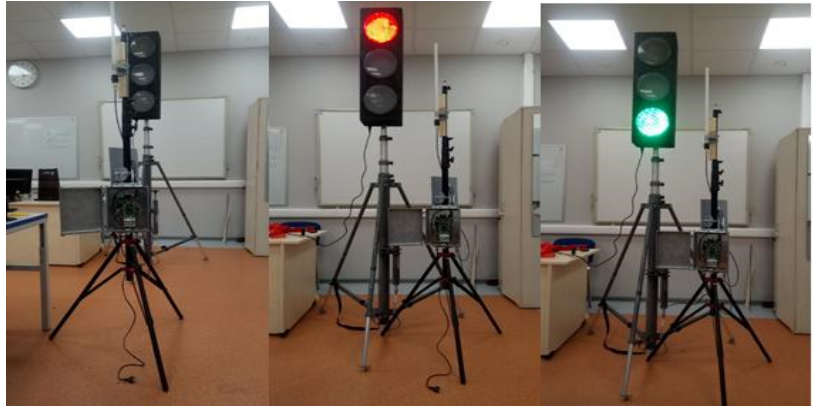
Future Internet 2019 , 11 , x FOR PEER REVIEW